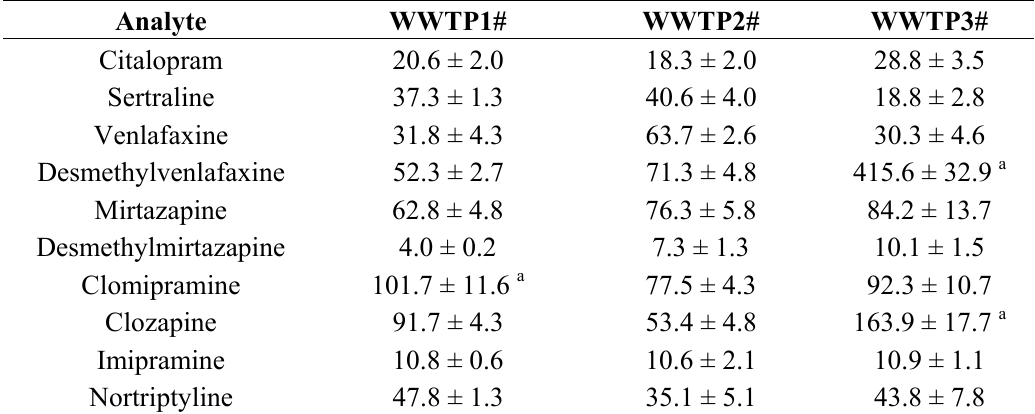
Table 3. Concentrations (ng/L) of antidepressants and their metabolites in wastewaters (n =